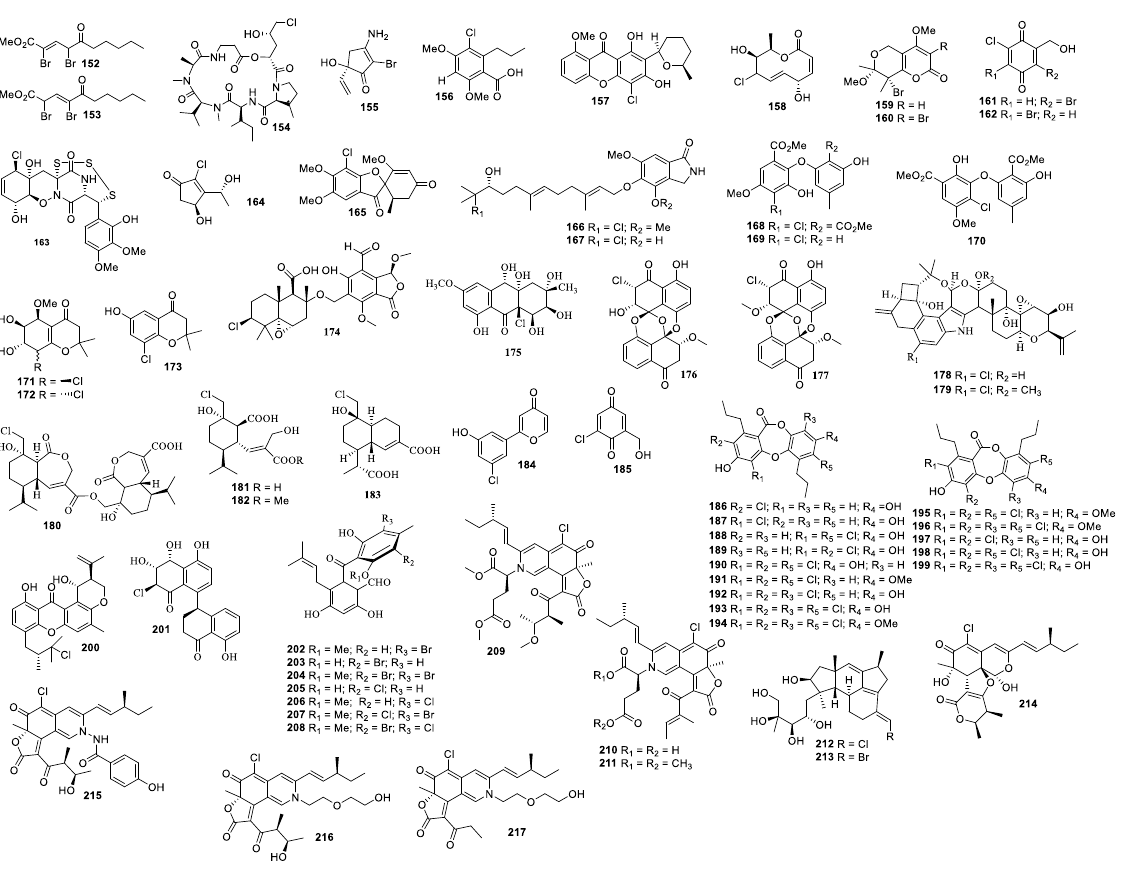
Figure 5. Structures of compounds 152 – 217.